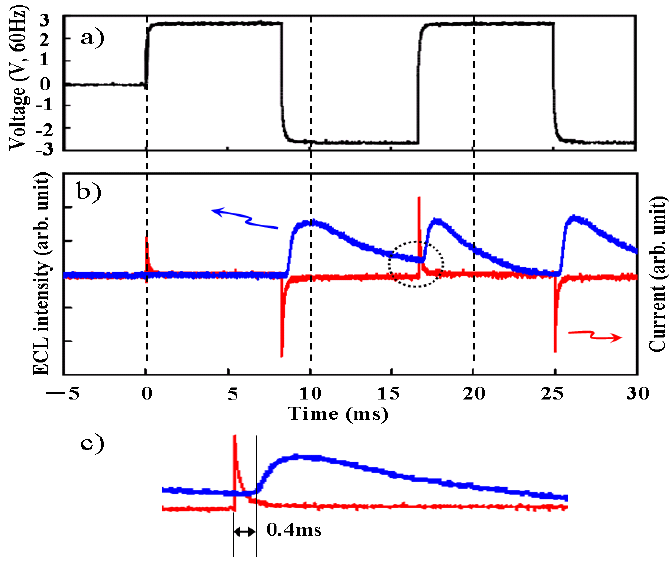
Figure 7. The transient response. (a) Voltage. (b) ECL intensity and current. (c) A magnification of the region enclosed in the dotted line in